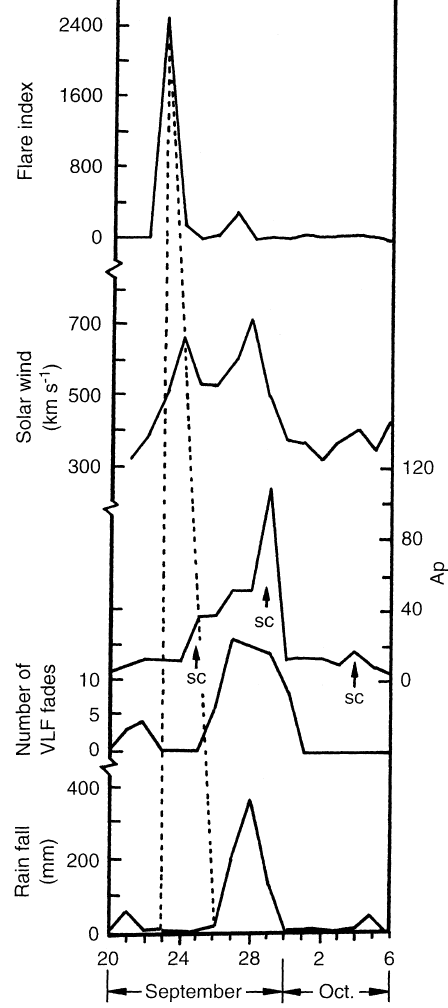
Fig. 7. Plot reveals the variation of solar geophysical and meteorolog- ical parameters, indicating a sequence of solar